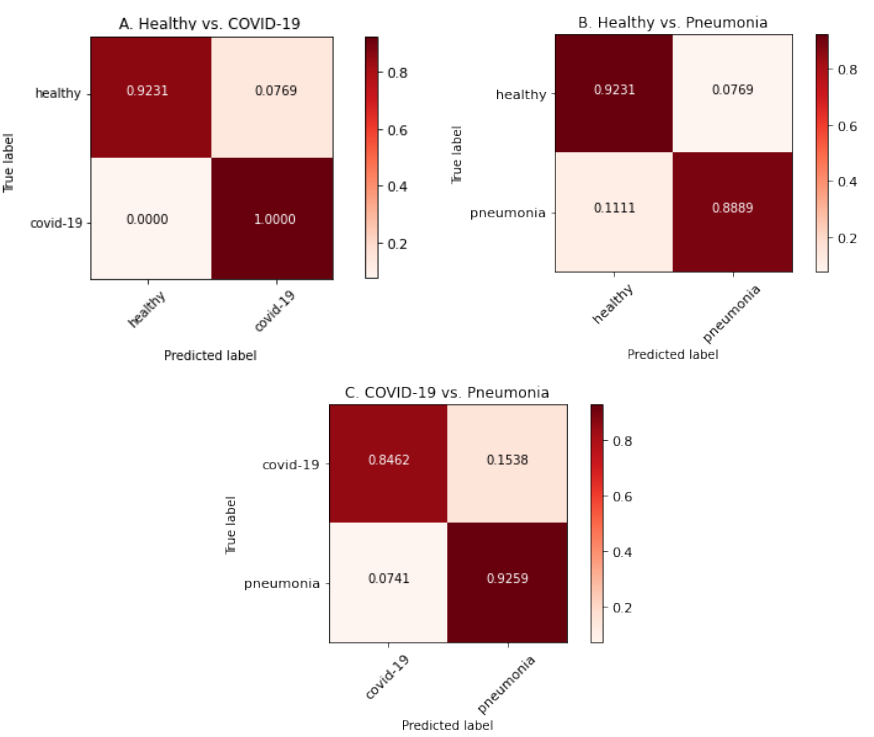
Figure 1. Confusion matrices for each model by using image samples for which it has been trained.